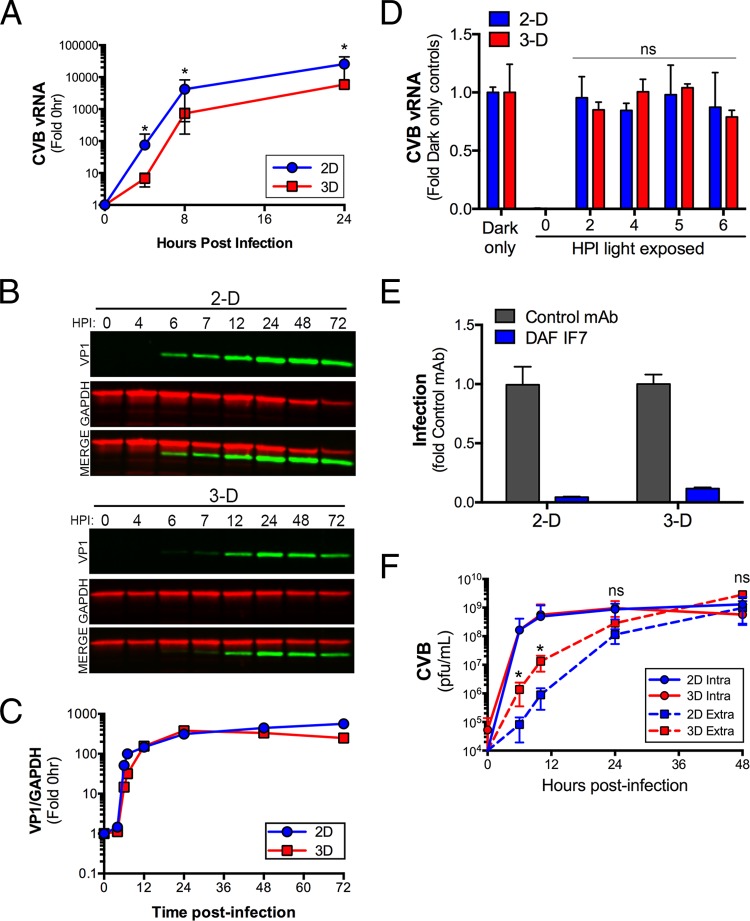
(A) RT-qPCR analyses of vRNA levels of 2-D and 3-D cultures of Caco-2 cells infected with CVB (10 PFU/cell) at the indicated hour postinfection (p.i.). Data are shown as fold change from 0 h p.i. (B) LICOR immunoblots for VP1 (green) and GAPDH (red) from 2-D and 3-D cultures of Caco-2 cells infected with CVB (10 PFU/cell) at the indicated hour postinfection (HPI). Representative data from a single (of three total) STLVs are shown. (C) Densitometry from immunoblots shown in panel B. Data are shown as the levels of VP1 normalized to the level of GAPDH at the indicated times p.i. (D) RT-qPCR analyses of CVB vRNA from 2-D or 3-D cultures of Caco-2 cells infected with light-sensitive neutral red (NR)-containing CVB (1 PFU/cell) and exposed to light at the indicated hours postinfection (HPI). In parallel, cultures were infected with NR-CVB in the dark. Data are shown as fold change from dark-only control infections. (E) RT-qPCR analyses of CVB vRNA from 2-D or 3-D cultures of infected Caco-2 cells or cells pretreated with a control monoclonal antibody (mAb) or anti-DAF IF7 blocking monoclonal antibody. Data are shown as fold change (mean plus standard deviation [error bar]) from the level with the control MAb. (F) CVB titers (in PFU per milliliter) of virus collected from the medium (extracellular [Extra]) (dashed lines) of 2-D or 3-D cultures of Caco-2 cells infected with CVB for the indicated hours postinfection. In addition, CVB titers from cells (intracellular [Intra]) (solid lines) from CVB-infected 2-D or 3-D cultures are shown. Data in panel A and panels D to F are shown as means plus standard deviations and are averaged from three (A and F) or two (D and E) independent STLVs. Values that are significantly different (P < 0.05) by a Student’s t test are indicated by an asterisk. Values that are not significantly different (ns) as determined by a Student’s t test are also indicated.